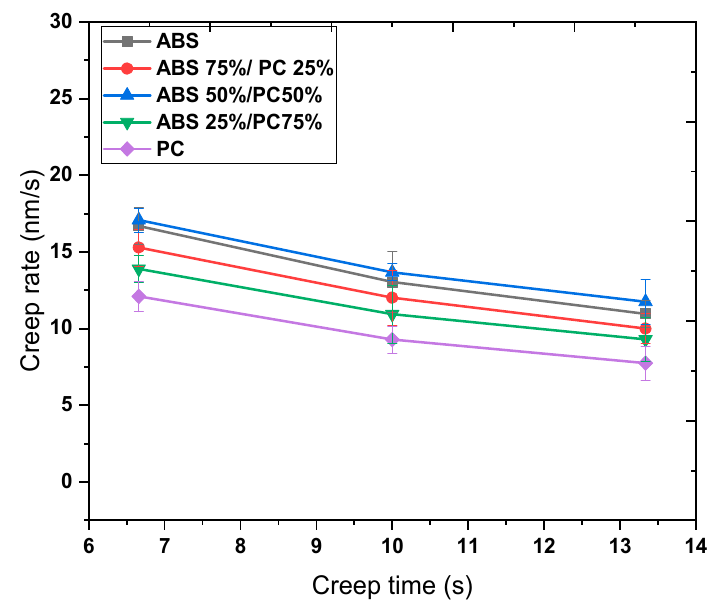
Figure 6. Creep rate vs. time for ABS, PC, and ABS/PC blends. Neat PC, on the other hand, showed a lower value and its rate changed from 12.1 to 7.8 nm/s. ABS 50%/PC 50% blend showed a maximum value of creep rate at the same conditions, which is not following the trend of all other samples. This difference may have risen due to improper mixing of the blend contents. Overall, a decrease of 8.4% and 16.7% was observed in the case of ABS 75%/PC 25% and ABS 25%/PC 75%, respectively, with the addition of PC in ABS. Figure 7 shows the creep time plotted as a function of depth change. It represented the creep time effect on the depth change of ABS, ABS/PC blends, and PC at a peak load of 100 mN. The depth of ABS varied from 106.6 to 339.5 nm while PC depth changed from 79.4 to 232.8 nm. Blends of ABS/PC showed mixed trends; depth was decreased as the PC content was increased. Although 50% ABS/50% PC trend was different from other blends, it showed highest depth achieved at 348.9 nm. This difference may be due non-uniform mixing and presence of voids in the sheet.